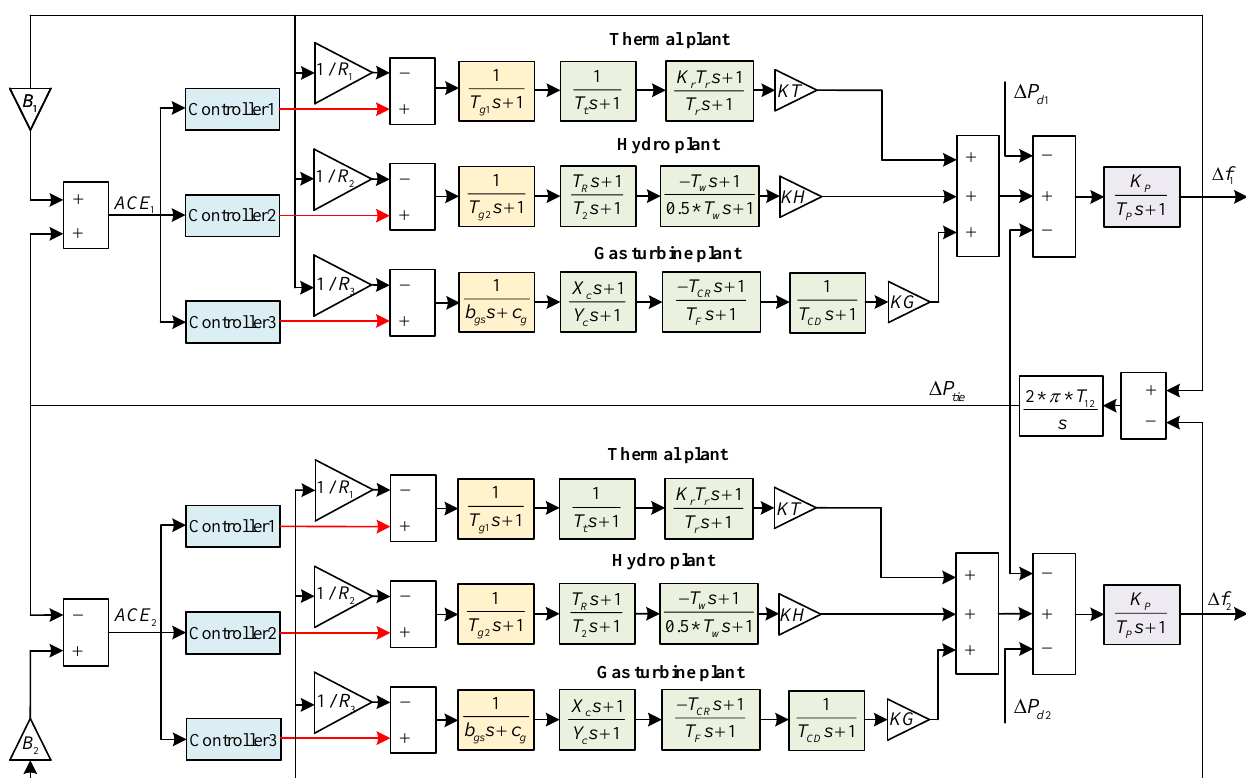
Figure 1. Transfer function model of two-area six-unit power